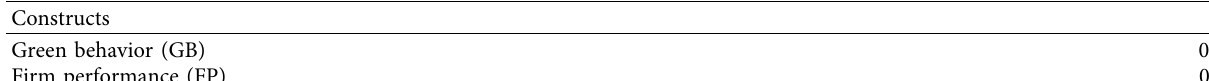
Figure 2: SmartPLS bootstrap graph. Table 3: R 2 of the dependent